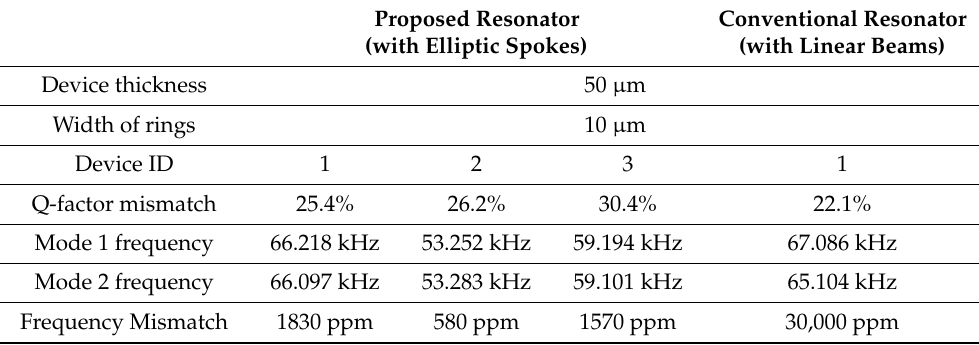
Table 2. Experimental results of fabricated conventional resonator and proposed